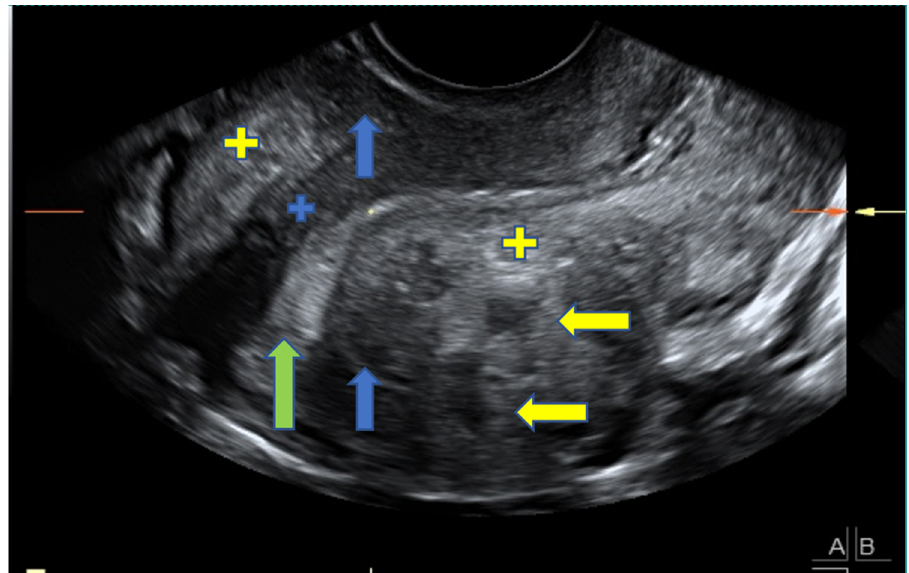
Figure 1. 2D transvaginal longitudinal ultrasound image in a symptomatic patient, depicting the uterus with sonographic signs typical of adenomyosis: asymmetrical myometrial thickening (blue arrows), linear striations (blue plus sign), myometrial cysts (yellow arrows), hyperechoic islands (yellow plus sign), and an S-shaped endometrium (green arrow).